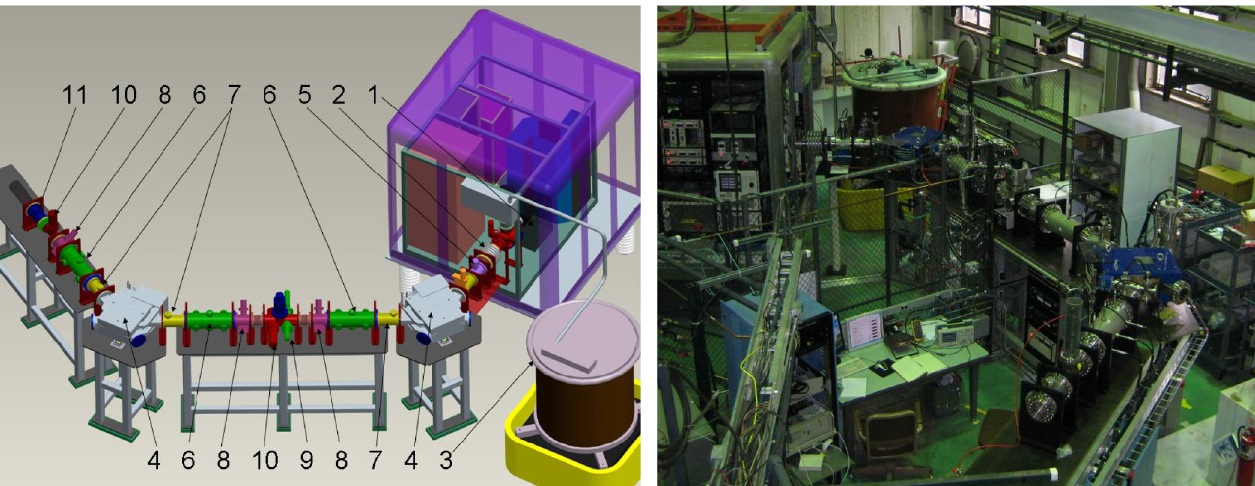
FIG. 1. (Color) General view of the injector. The picture on the left is the engineering model while the right picture is photo of the injector: 1, all permanent magnet ECRIS installed on HV platform; 2, 75-kVaccelerating tube; 3, isolation transformer; 4, 60 (cid:3) bending magnet; 5, Einzel lens; 6, electrostatic triplet; 7, electrostatic steering plates; 8, rotating wire scanner; 9, horizontal jaw slits; 10, Faraday cup; 11, emittance